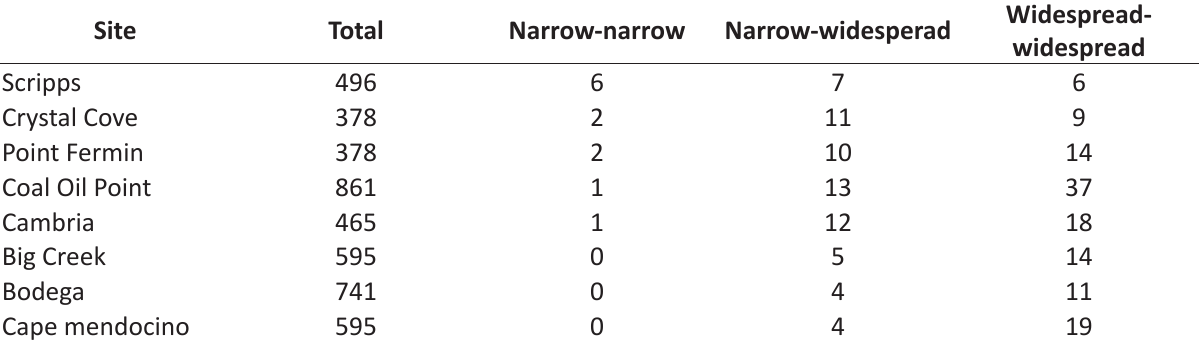
Table 1. Number of species associations at each site: total, narrow-narrow, narrow-widespread, and widespread-widespread